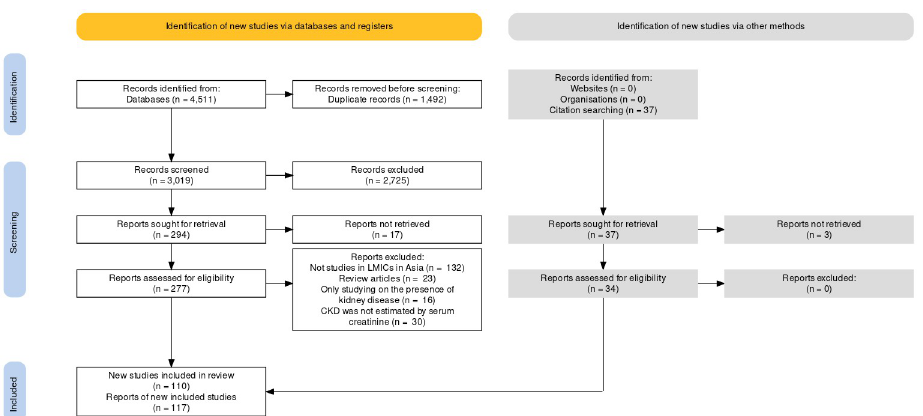
Fig 1. PRISMA flow chart for identifying relevant